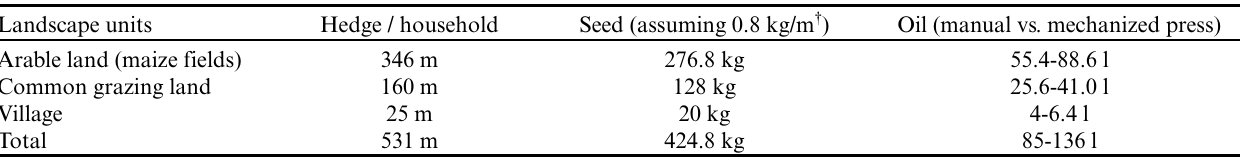
Table 1 . Potential yield scenarios for three different landscape units.